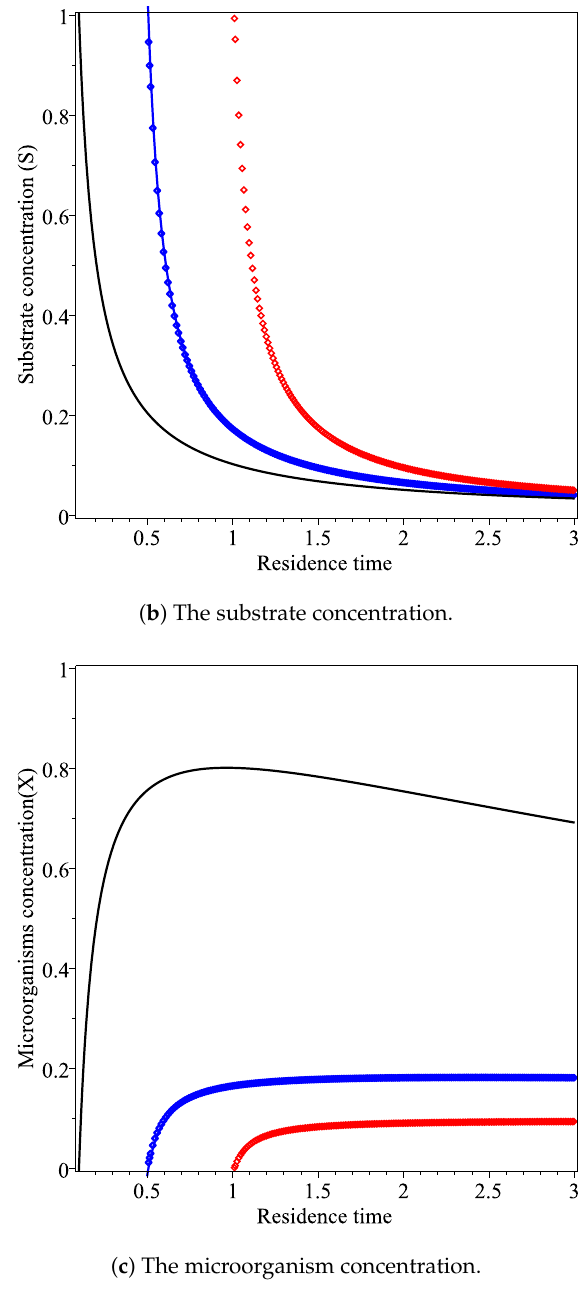
Figure 1. A steady-state diagram of the oxygen concentration, the substrate concentration, and the microorganism concentration varying the residence time τ for different values of parameter β . The value of the parameters stated in Table 1. β = 0.1 (Black color), β = 0.5 (Blue color), β = 1 (Red color). Figure 2 is an unfolding diagram for the minimum residence time in Figure 1a as a function of β and the influent concentration ( S 0 ). We note that the minimum residence time increases as the value of these parameters